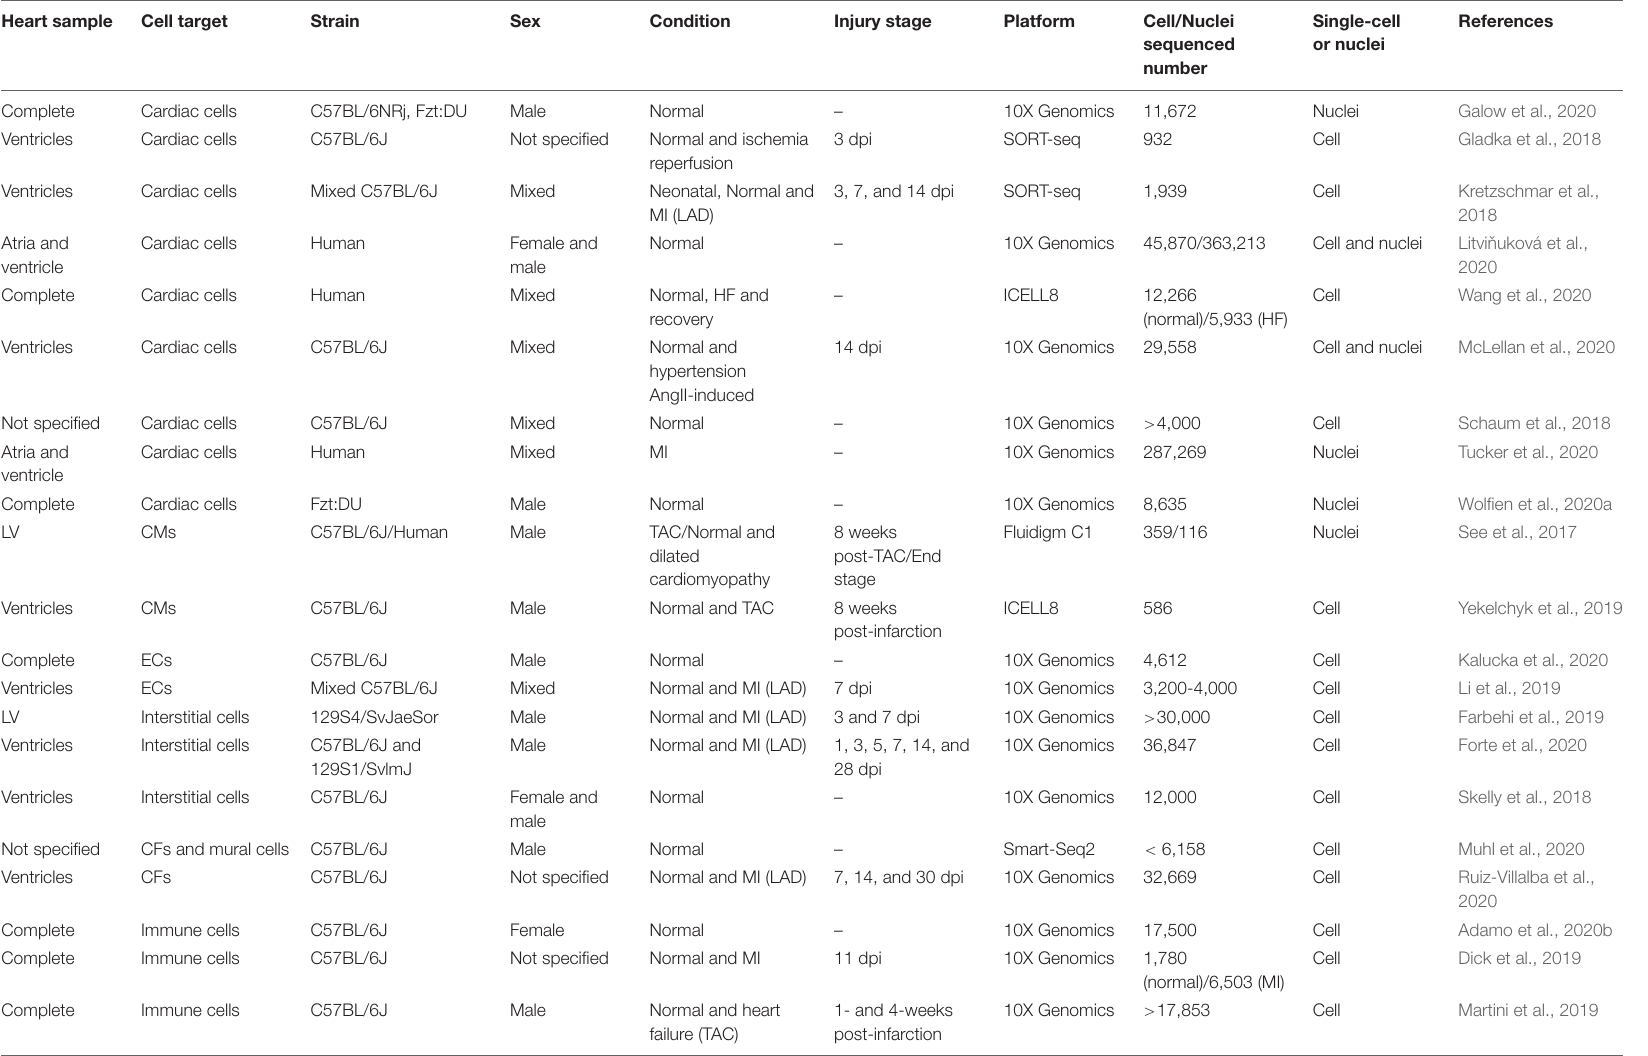
TABLE 1 | Summary of single-cell RNA-Seq analyses performed in the adult mammalian